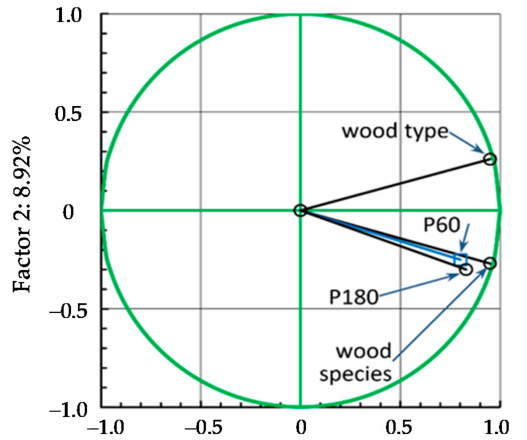
Figure 6. The result of principal component analysis (PCA) for the entire population of